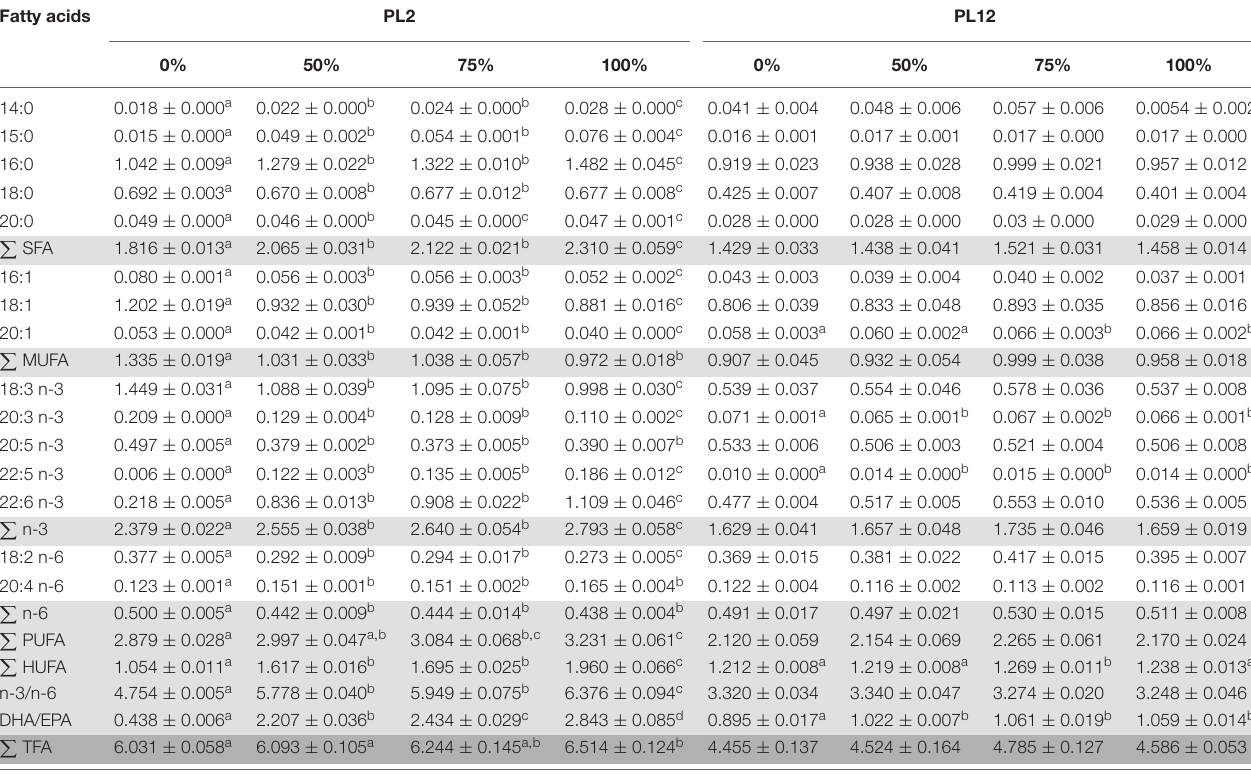
TABLE 4 | Fatty acid profiles (% dry weight) of shrimp fed with different diets analyzed by GC-FID. Fatty